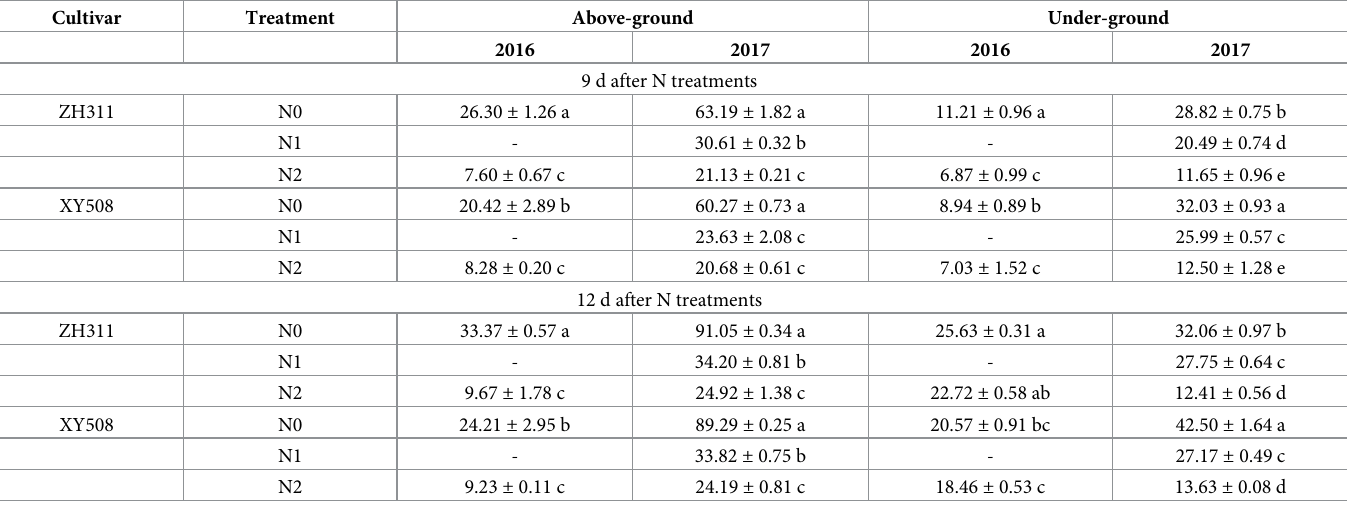
Table 2. Soluble sugar content in maize at the seedling stage under different nitrogen treatments (mg g -1 ). Cultivar Treatment Above-ground